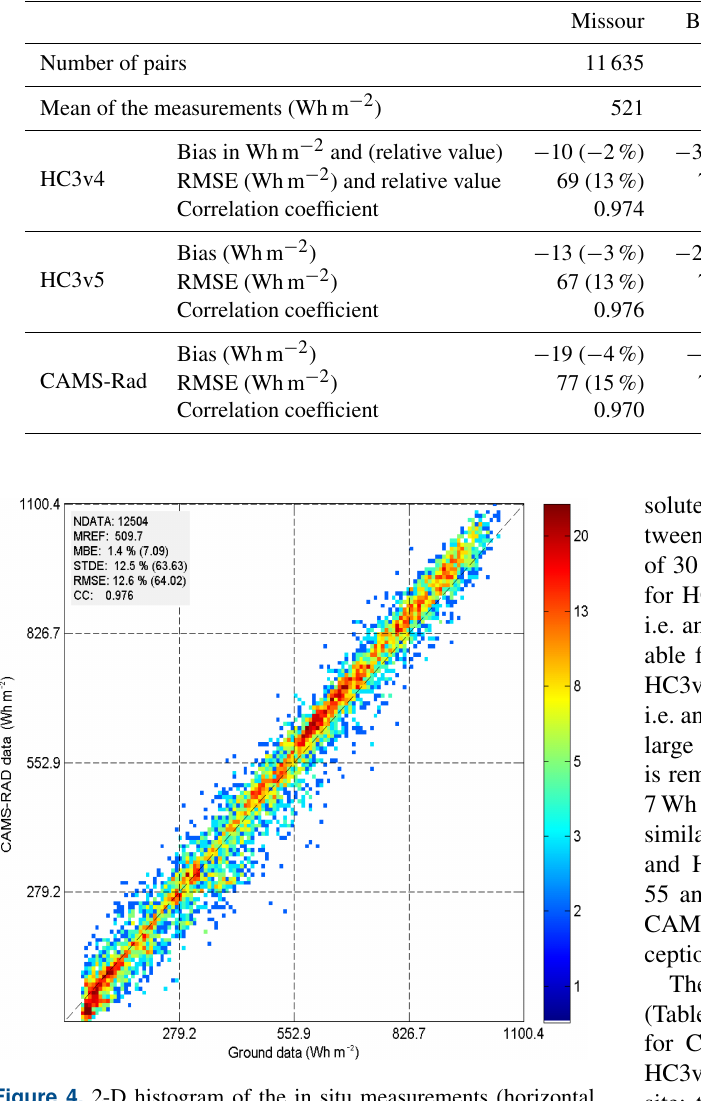
Figure 4. 2-D histogram of the in situ measurements (horizontal axis) and CAMS-Rad estimates (vertical axis) at Erfoud. The num- ber of samples (NDATA), the mean of the measured hourly irra- diations (MREF), the bias (MBE), the standard-deviation (STDE), root mean square of the errors (RMSE), in Whm − 2 , and the corre- lation coefficient (CC) are reported in the upper left corner. Relative values are obtained by the division of the quantity by